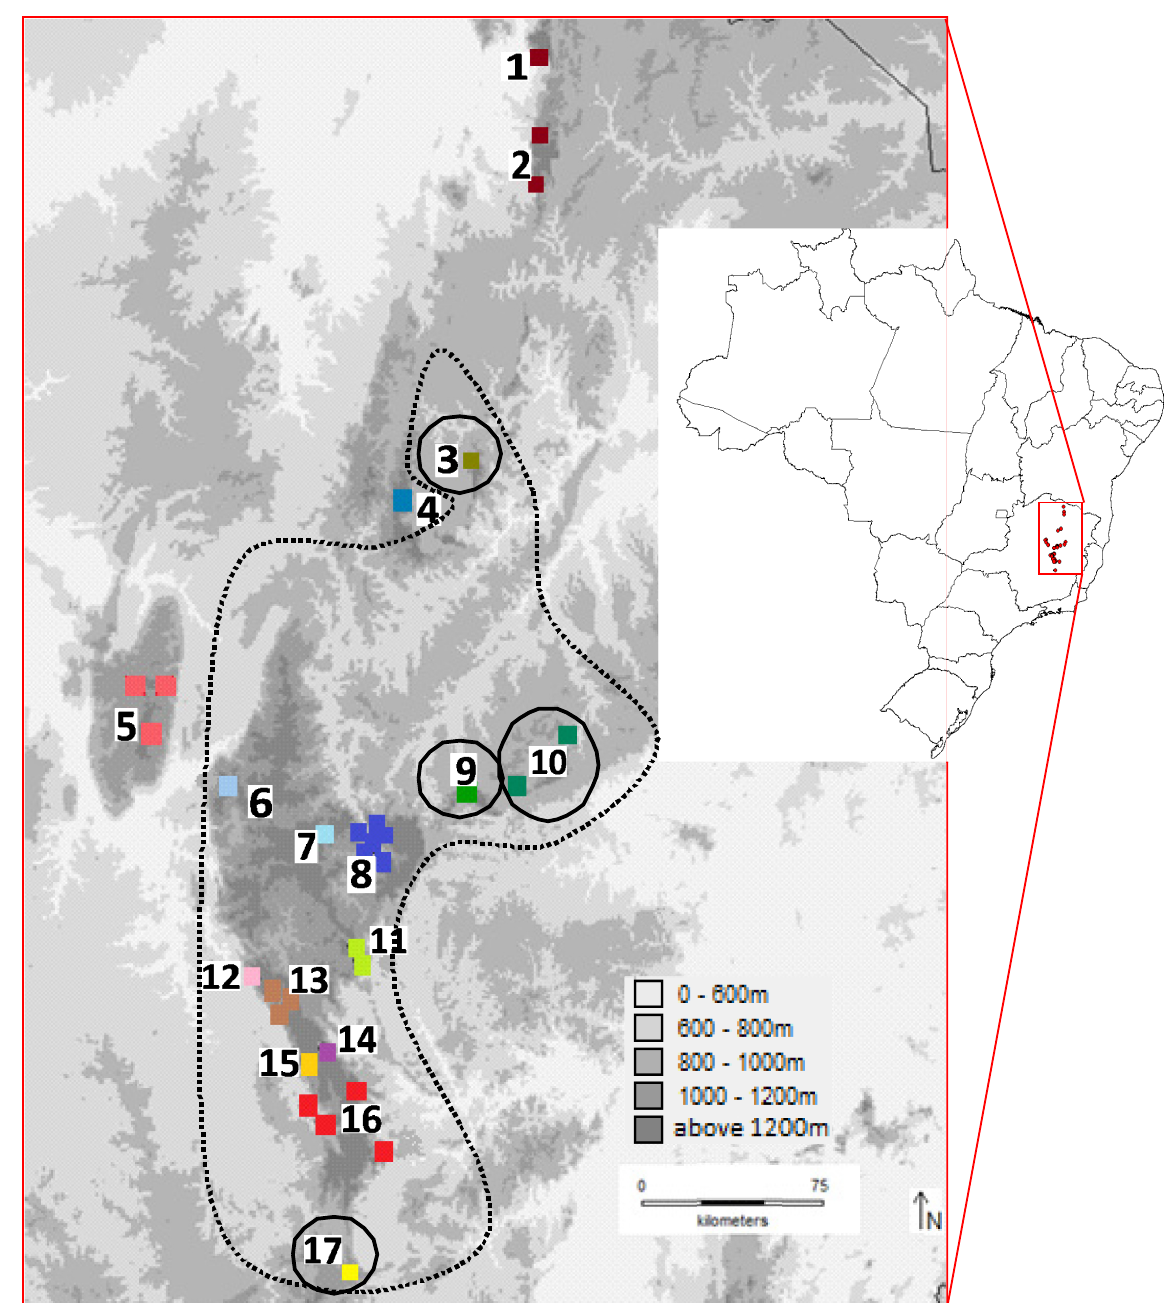
Fig 1. Sample sites across the Espinhac¸o Range. The Southern Espinhac¸o region is within the dotted line. The sample points in the marginal areas are circulated. 1: Serra da Formosa; 2: Serra Nova; 3: Serra de Botumirim; 4: Serra de Itacambira; 5: Serra do Cabral; 6: A´guas de Santa Ba´rbara; 7: Diamantina; 8: Rio Preto; 9: Serra do Ambro´sio; 10: Serra Negra; 11: Serra do Sapo; 12: Alto de Fechados; 13: Serra Talhada; 14: Conceic¸ ã o do Mato Dentro; 15: Lapinha da Serra; 16: Serra do Cipo´; 17: Serra da A´gua